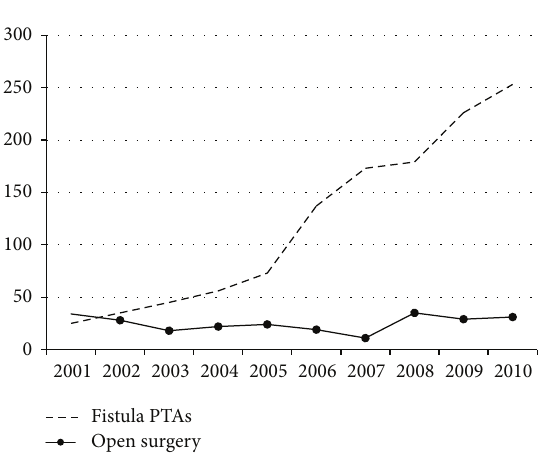
Figure 2: (a) Patient with right radiocephalic fistula and recurrent stenosis of the proximal portion of his cephalic vein (arrow). (b) The lesion has been dilated on three occasions during two years. This is the third PTA. This is particularly important for this patient whose fistulas in the left arm have